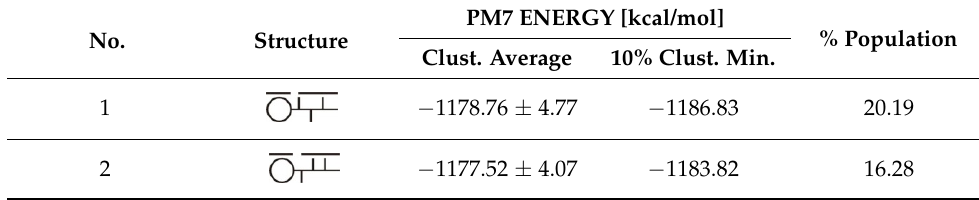
Table 7. Diastereomer 2 C5( S ), PM7 clusters energies.